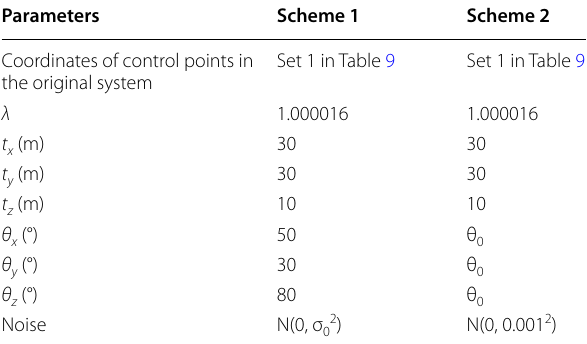
Table 14 The settings of two test